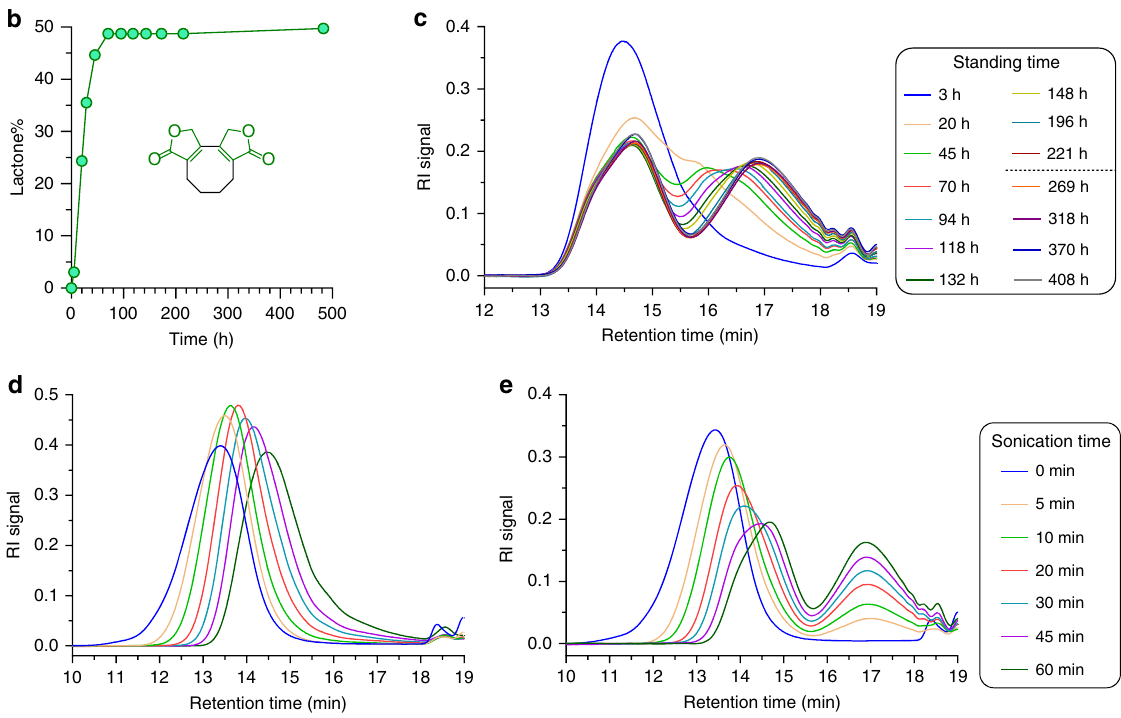
Fig. 5 Ultrasonication study of polymer P3. a Scheme of mechanical activation of BCOE and g DCC in P3 and following spontaneous lactonization. 1 H NMR characterization of activated g DCC and generated lactone in a P3 polymer that was sonicated for 60 min and set for 21 days to reach full lactonization. b 1 H NMR (CDCl 3 ) quanti fi cation of lactone formation over standing time in a P3 polymer post 60 min sonication. c GPC trace evolution of P3 polymer after 60 min sonication over various standing time in THF. GPC analysis of sonicated P3 immediately after sonication ( d ) and after 17 days standing time ( e ). The legends for d and e are indicated on the